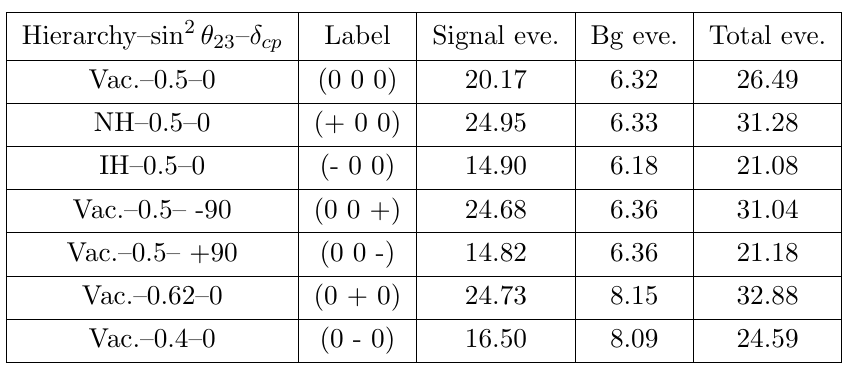
Table 2 . Number of (cid:23) e appearance events for one year (cid:23) run of NO (cid:23) A. They are listed for the reference point and for change of one unknown at a